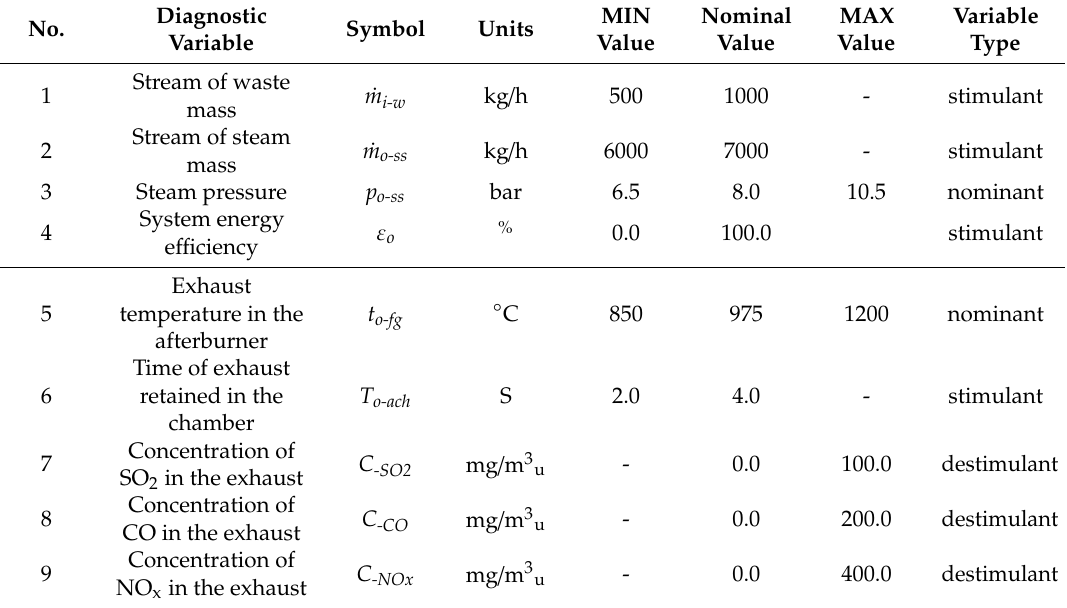
Table 1. List of boundary conditions for the main parameters of the waste thermal treatment process defined for the tested